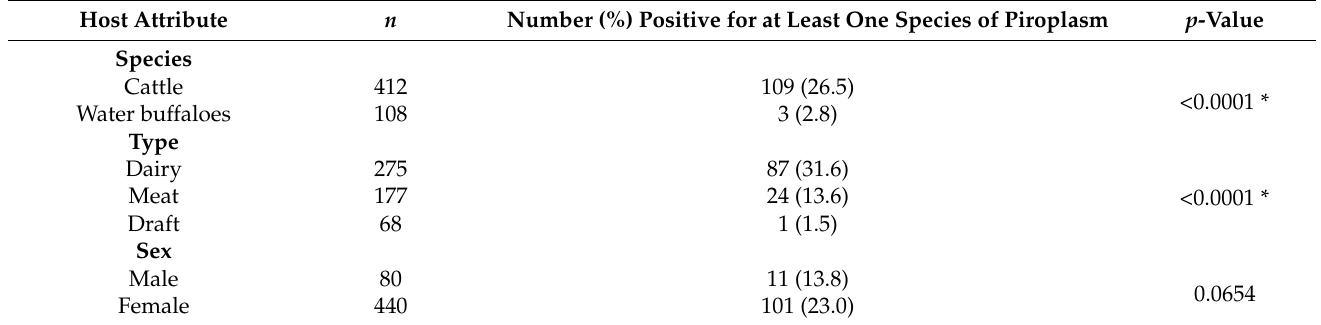
Table 3. Host attributes of cattle and water buffaloes from selected provinces in Luzon, Philippines, that tested positive for piroplasms based on species-specific PCR. n = total number of